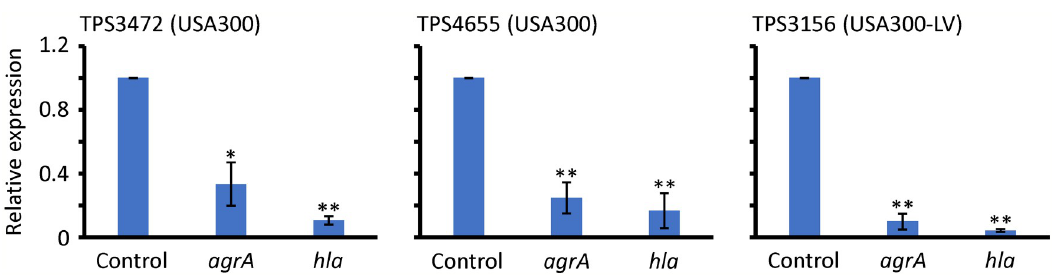
Fig 5. agrA and hla genes expression in the presence and absence of Tokiinshi (2.5 mg/ml). � P < 0.05 and �� P < 0.01 vs. control.